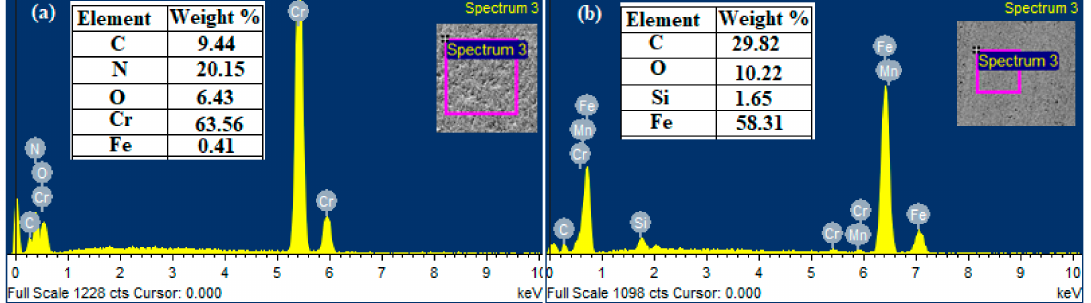
Figure 1. ( a ) The composition of chromium nitride (CrN) sample before sliding wear test by EDS, ( b ) The composition of counter-body before sliding wear test by EDS.